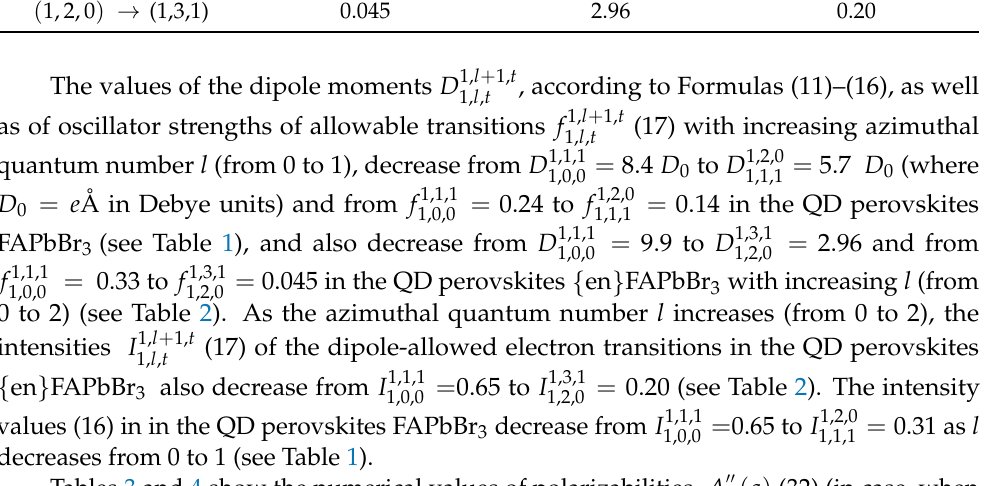
(17) transition dipole moments D 1, l + 1, t 1, l , t 1, l , t (18) caused by dipole-allowed 1, l , t